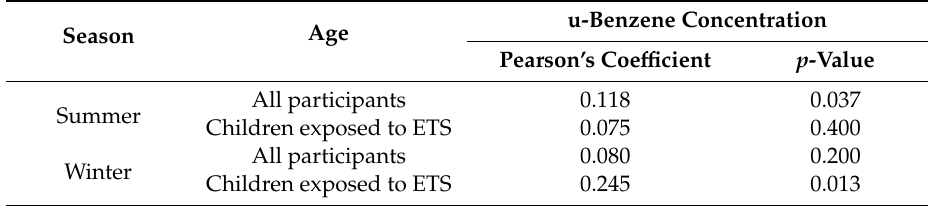
Table 6. Pearson’s correlation between u-Benzene concentrations (ng L − 1 , expressed as natural log transformed data) and age for all participants and just considering the group of children exposed to ETS or number of cigarettes smoked total or home /